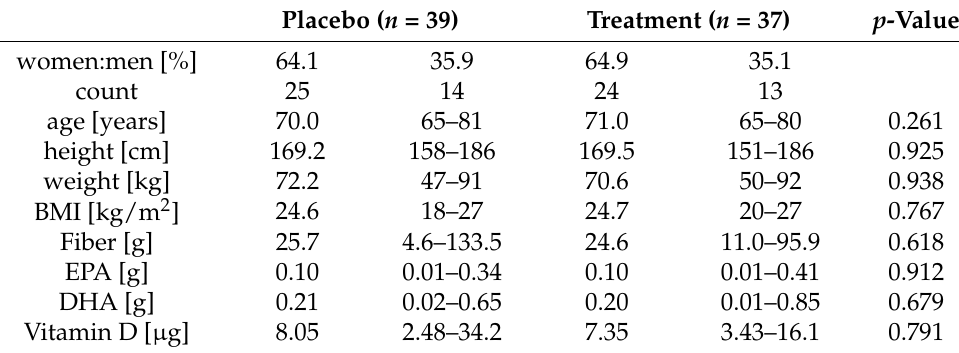
Table 1. Participant characteristics at